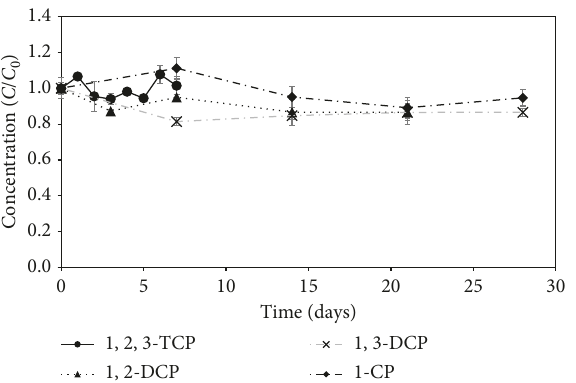
Figure 2: Degradation of 1,2,3-TCP (12.1mg/l), 1,2-DCP (9.55 mg/L), 1,3-DCP (24.79 mg/L), and 1-CP (26.49mg/L) in the presence of 0.5g of µ